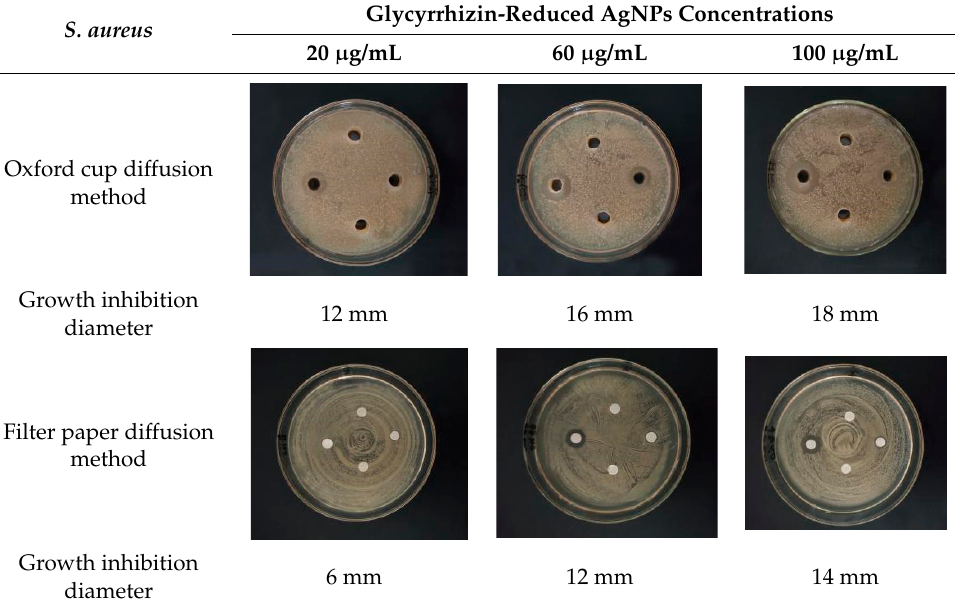
Table 2. Diagram of the bacteriostatic effect of GL-reduced AgNPs ( S. aureus ).